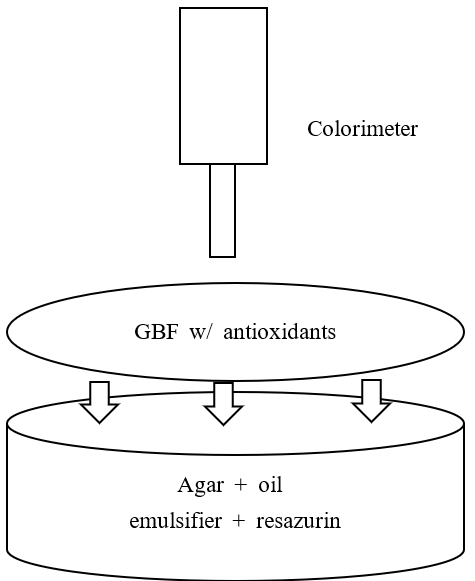
Figure 8. Diagram of highly lipid-based simulation food system (AES-R) for antioxidation activity test. Note that the AES-R system is composed of agar (polysaccharide), oil (soybean oil), emulsifier (Tween 80), and pH indicator (resazurin). GBF will be placed on the top surface of the AES-R system.